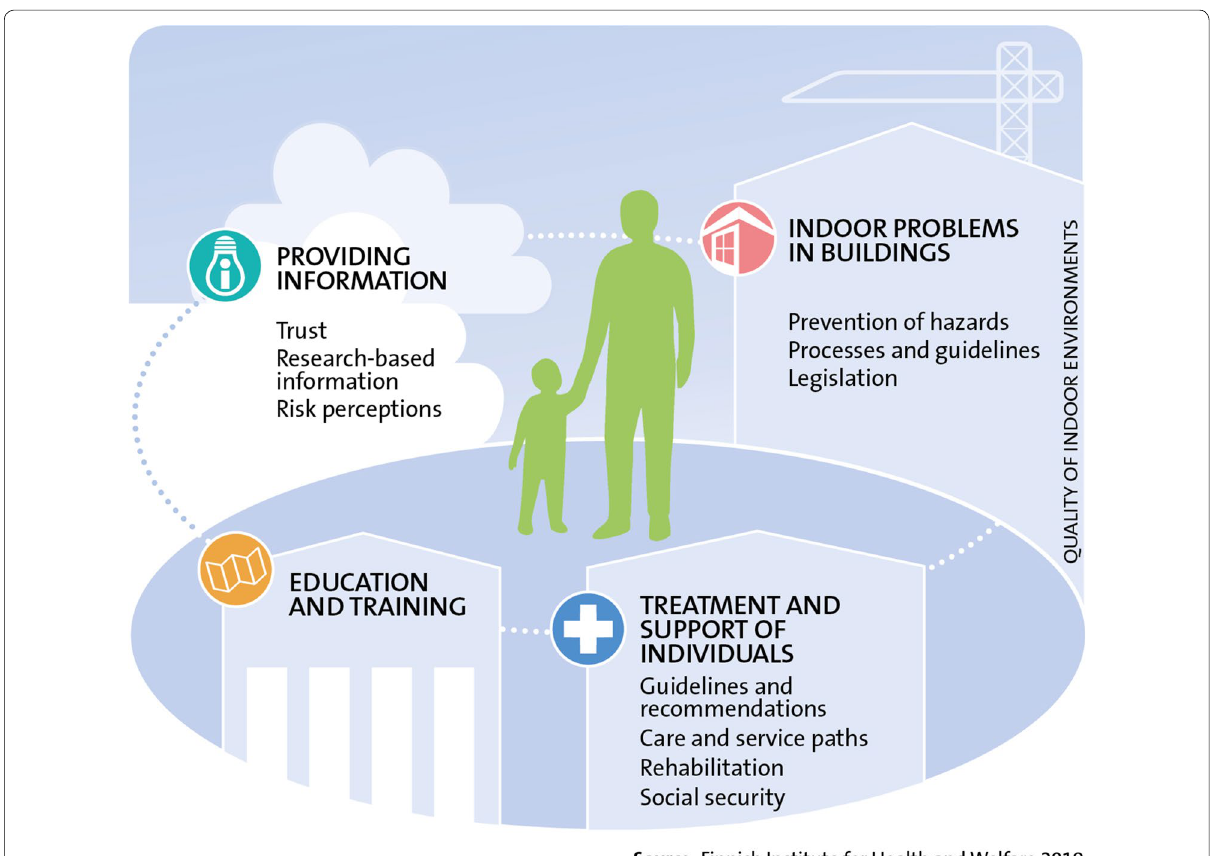
Fig. 5 The Finnish Indoor Air and Health Programme develops new evidence‑based methods, perspectives and solutions for solving problems related to indoor air and for treating and supporting people with symptoms and illnesses. The programme will focus on promotion of human health and well‑being, prevention of hazards, communication, and comprehensive treatment and support of people who are ill